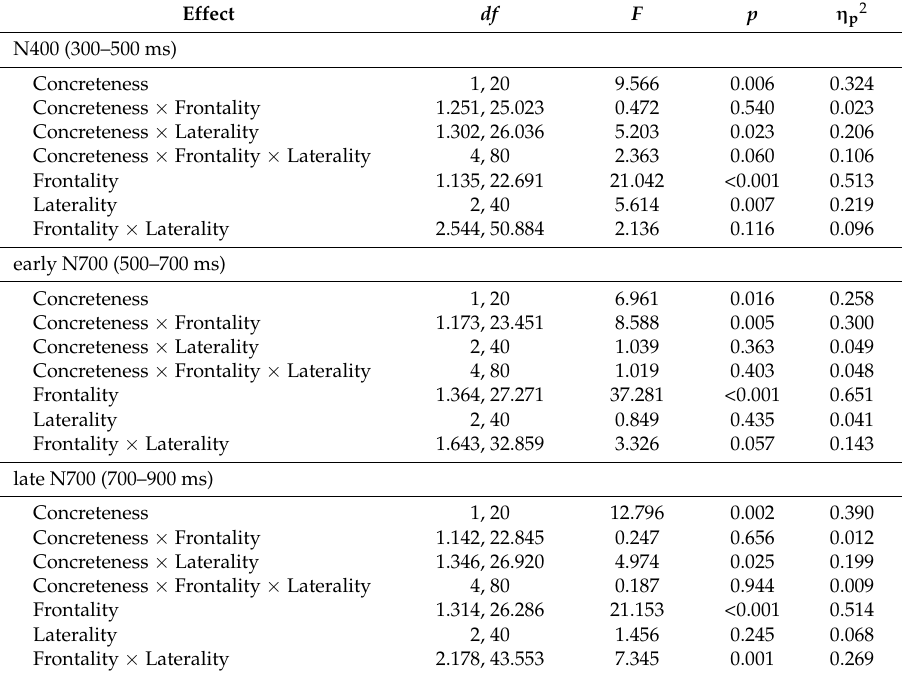
Table 1. Real Word Analyses. Full inferential statistics of the 2 × 3 × 3 repeated measures ANOVAs on N400, early N700 and late N700